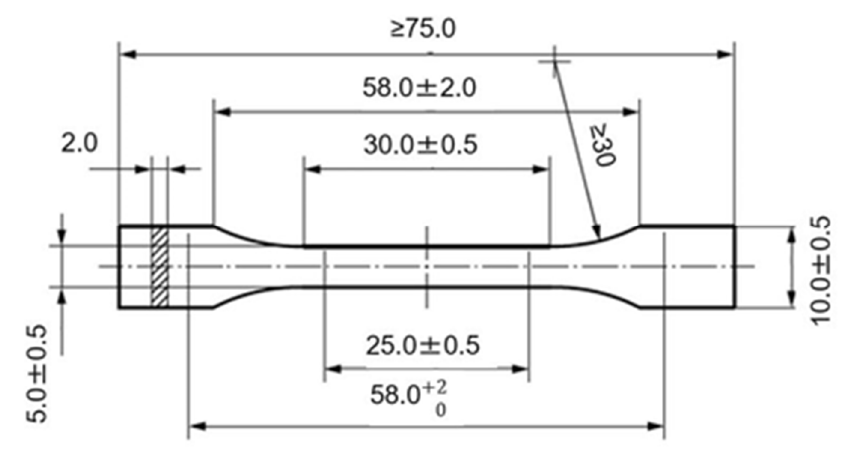
Figure 1. Specimen dimensions (in mm) based on ISO 527 I-BA.